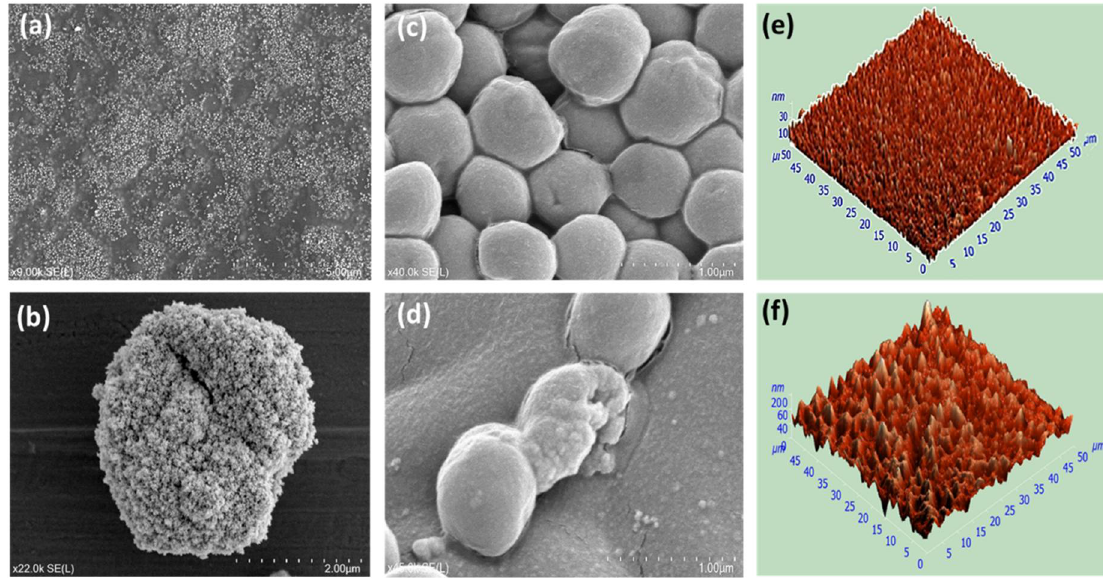
Figure 2. Properties of plasma polymer/ZnO composite films. ( a ) SEM image of ZnO NPs (~70–80 nm) embedded within a nanocomposite thin film acquired at ×9.0 k magnification. ( b ) SEM images of aggregation of some ZnO NPs presented in the composite acquired at ×22.0 k magnification. ( c ) and ( d ) SEM images of S. aureus cells cultured for 24 h (at 37 °C) on surfaces of control and Zn/Ge 10 W, acquired at ×40.0 k and 45.0 k magnification, respectively. Sterilized cover glass substrates were used as a control in all biological experiments. ( e ) and ( f ) Three-dimensional AFM images of pristine polymer and ZnO/composite surfaces measured at a scanning area of 50 µm × 50 µm.